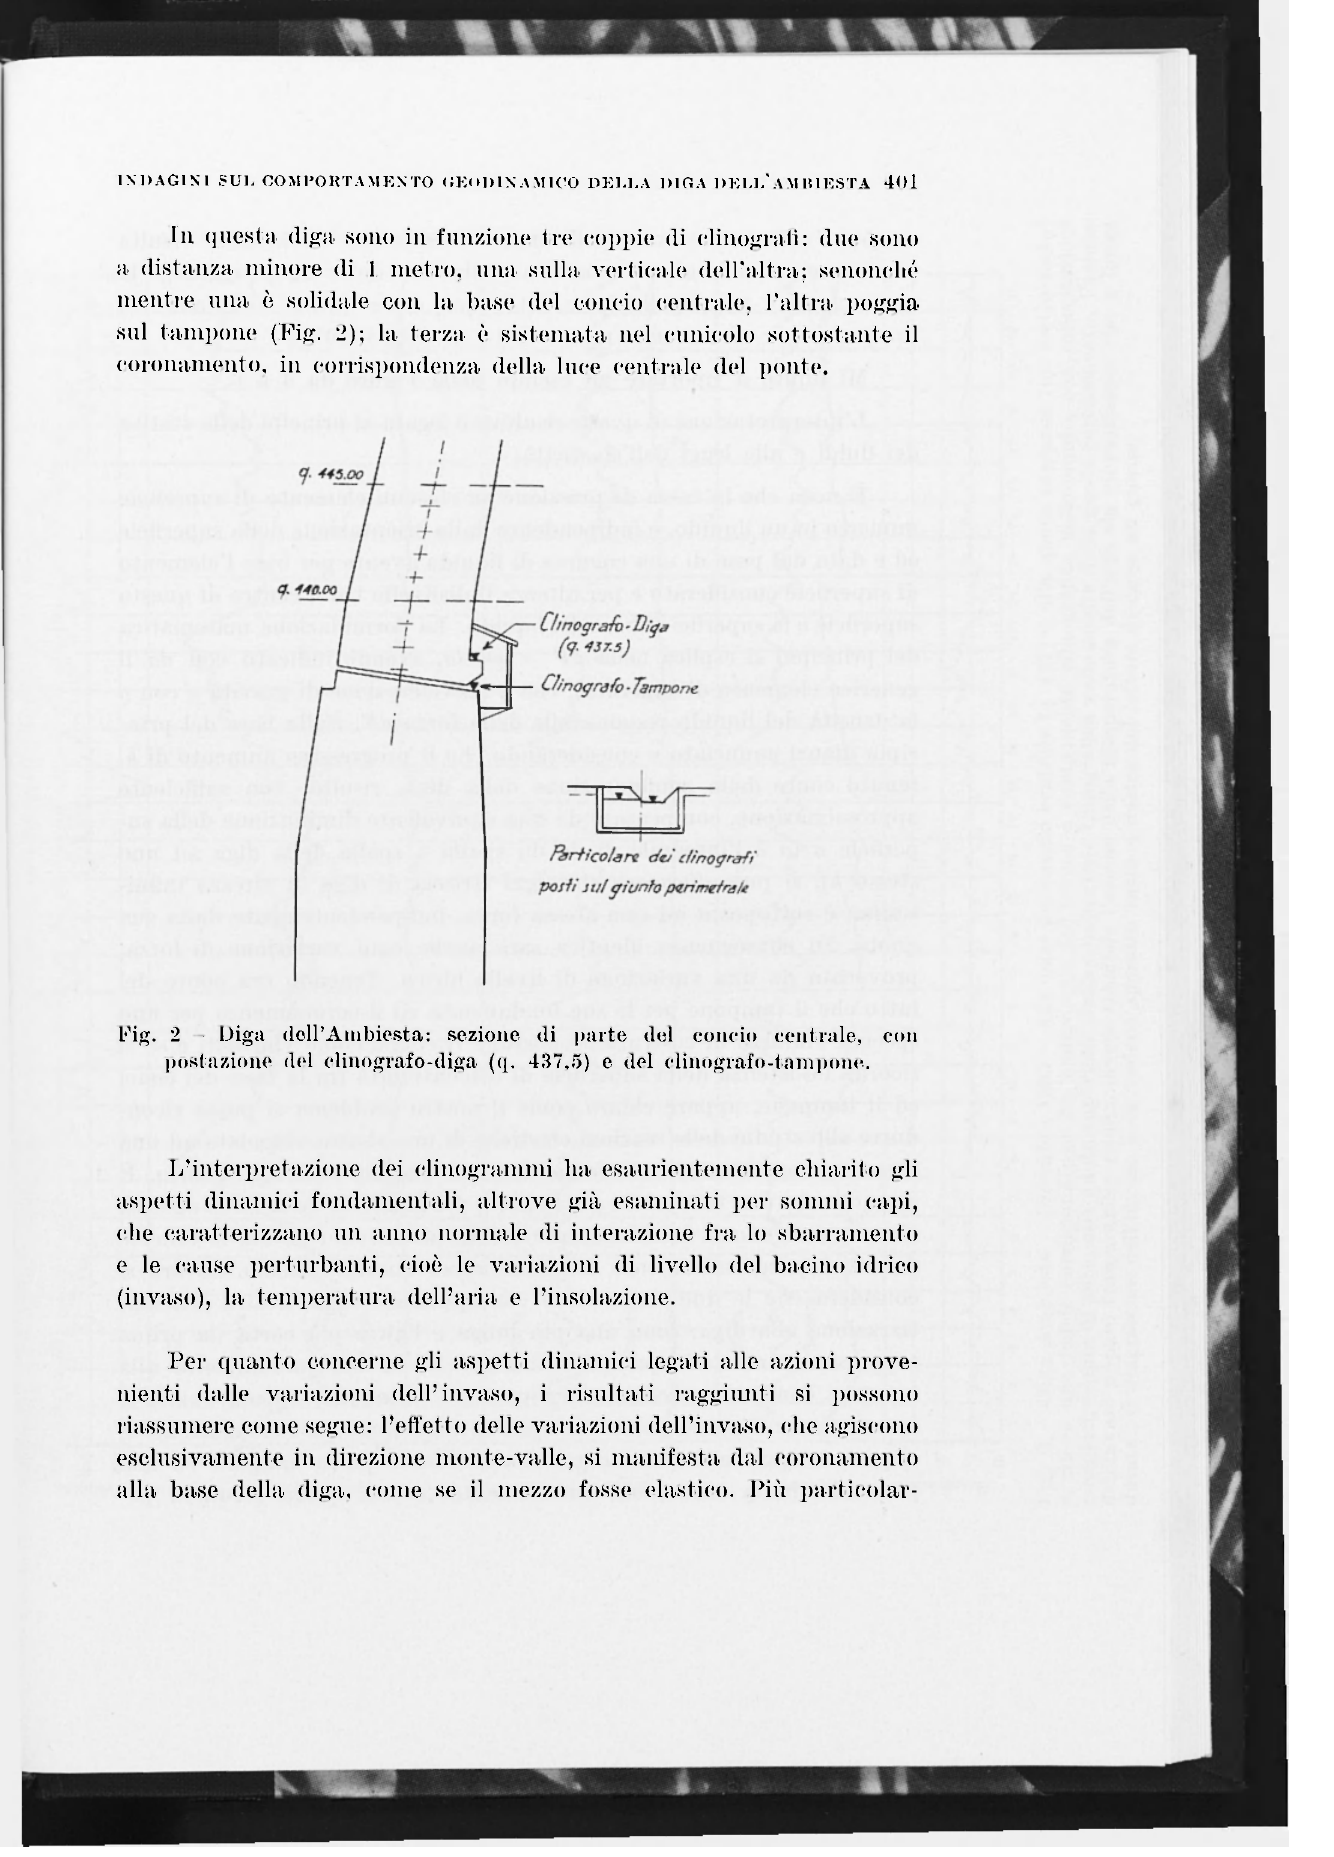
Diga (loll'Aiiibiesta: sezione di parte del concio centrale, con postazione del clinografo-diga (q. 437,5) e del clinografo-tampone.